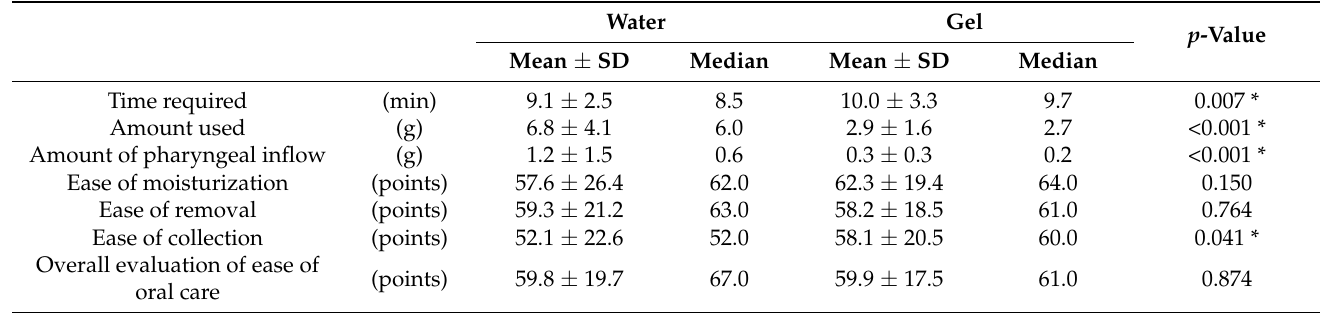
Table 1. Comparison of oral care with water and gel among all participants ( n = 90).